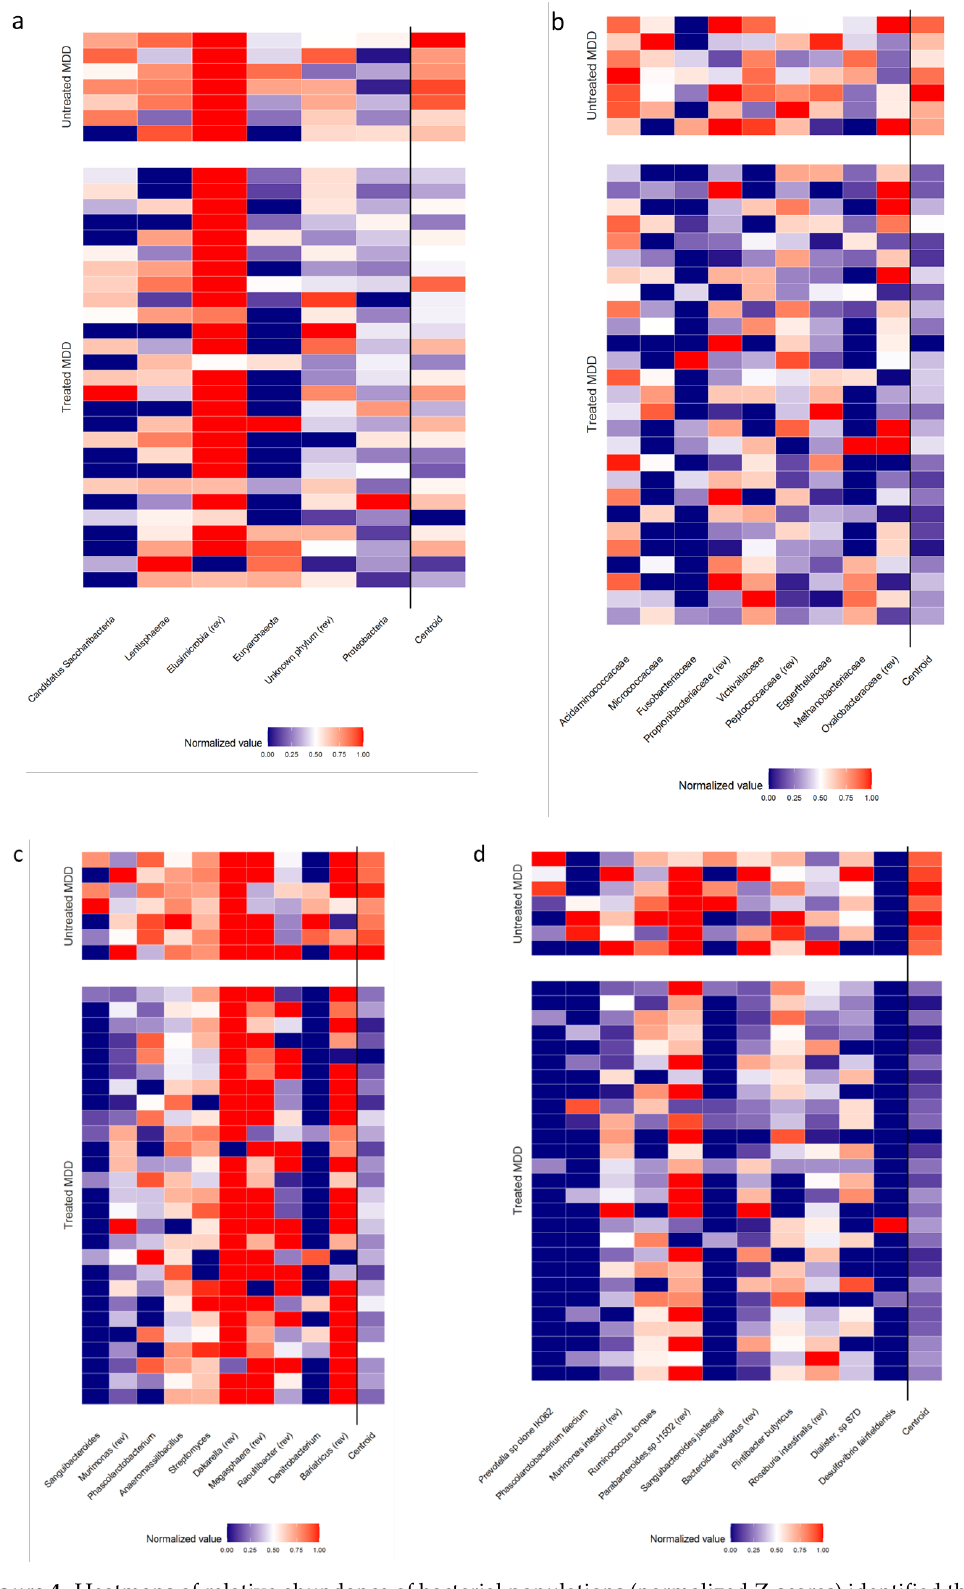
Figure 4. Heatmaps of relative abundance of bacterial populations (normalized Z-scores) identified the penalized logistic regression analysis algorithm, at phylum ( a ) family ( b ), genus ( c ) and species ( d ) levels grouped by treated and untreated patients with MDD. Abbreviation (rev): the sign of the specific bacterial’s normalized value was